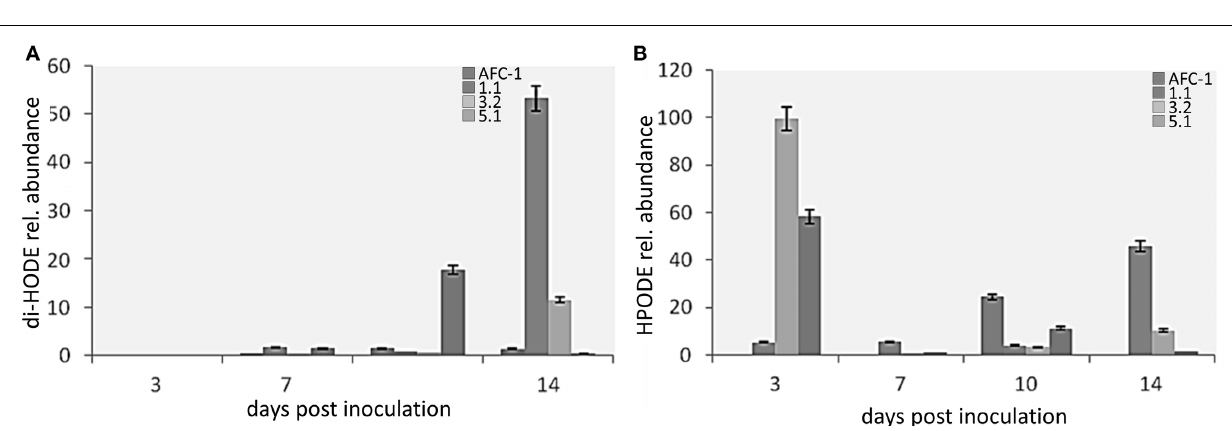
Af lox1 gene, Mn-lipoxygenase (LOX) encoding, knock-out mutants showed a significant reduction of mycelial growth and a complete inability to differentiate conidia and produce afla- toxins, if grown in vitro conditions. As shown by recent studies